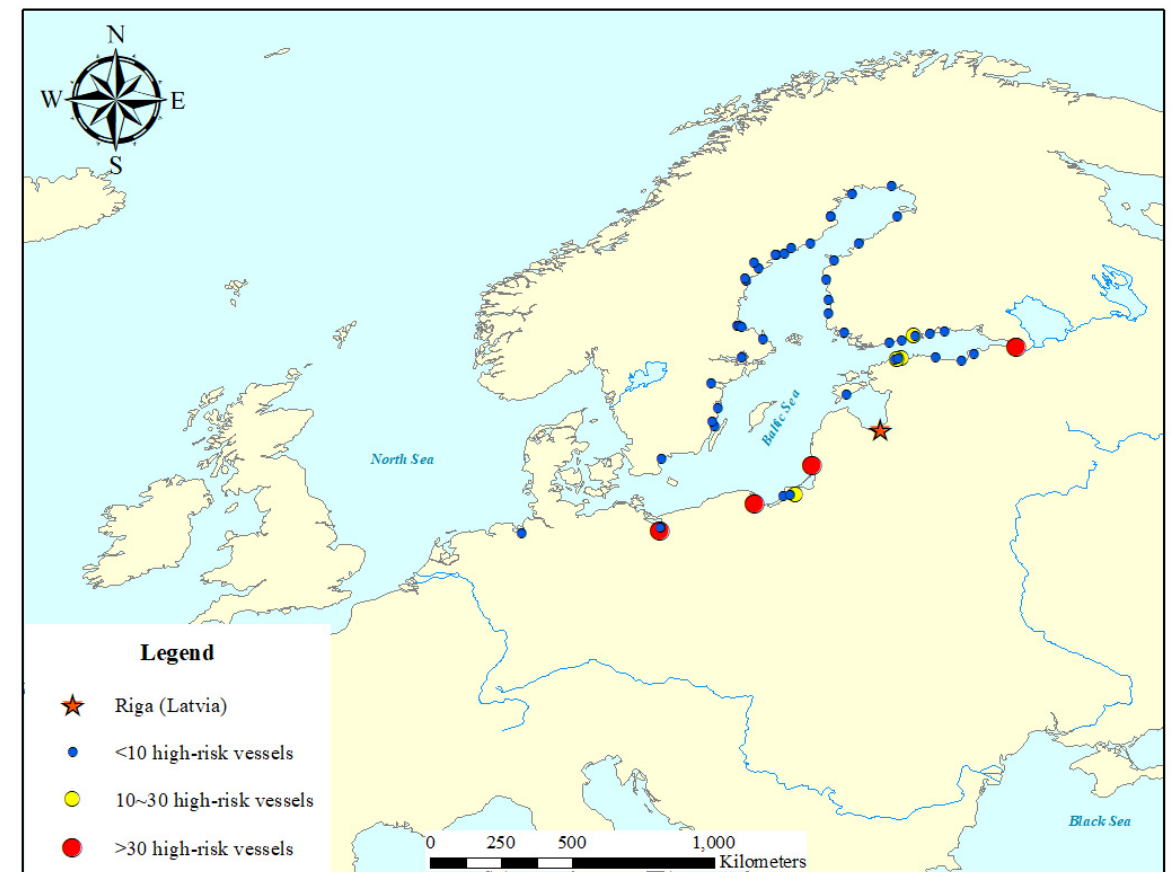
Figure 5. The results of the two-tier screening processes performed for the incoming vessels to the port of Riga.